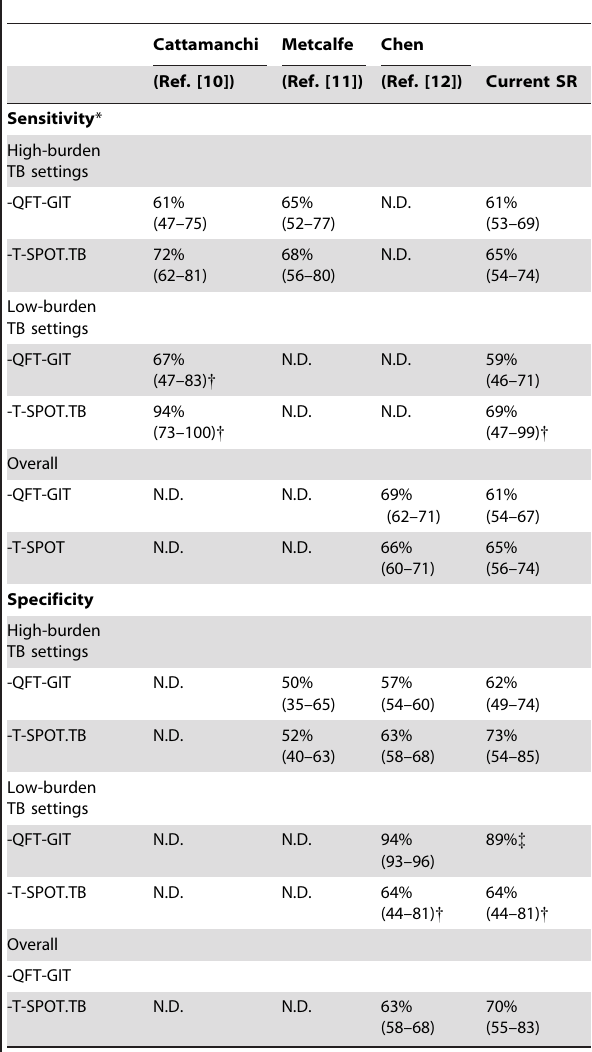
Table 7. Sensitivity and specificity of the IGRAs in HIV- infected patients in four systematic reviews.